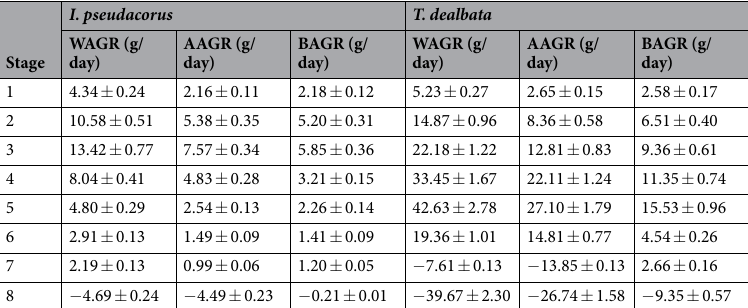
Table 2. Absolute growth rate (mean ± SD, n = 3) in different parts of plant after 28 days mesocosm experiment in each stage. WAGR is the whole plant absolute growth rate, AAGR is the above-ground tissues absolute growth rate and BAGR is below-ground tissues absolute growth